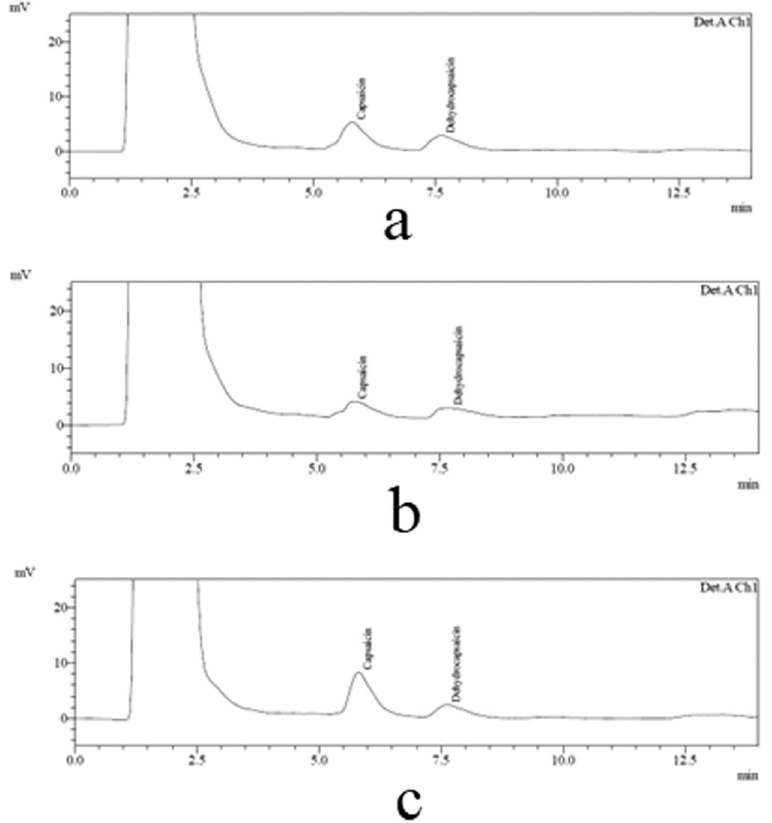
Figure 3: HPLC chromatogram of capsaicin and dihydrocapsaicin content in UNPAD CB2 ( a ) , Tanjung 2 ( b ) , and Lingga ( c )